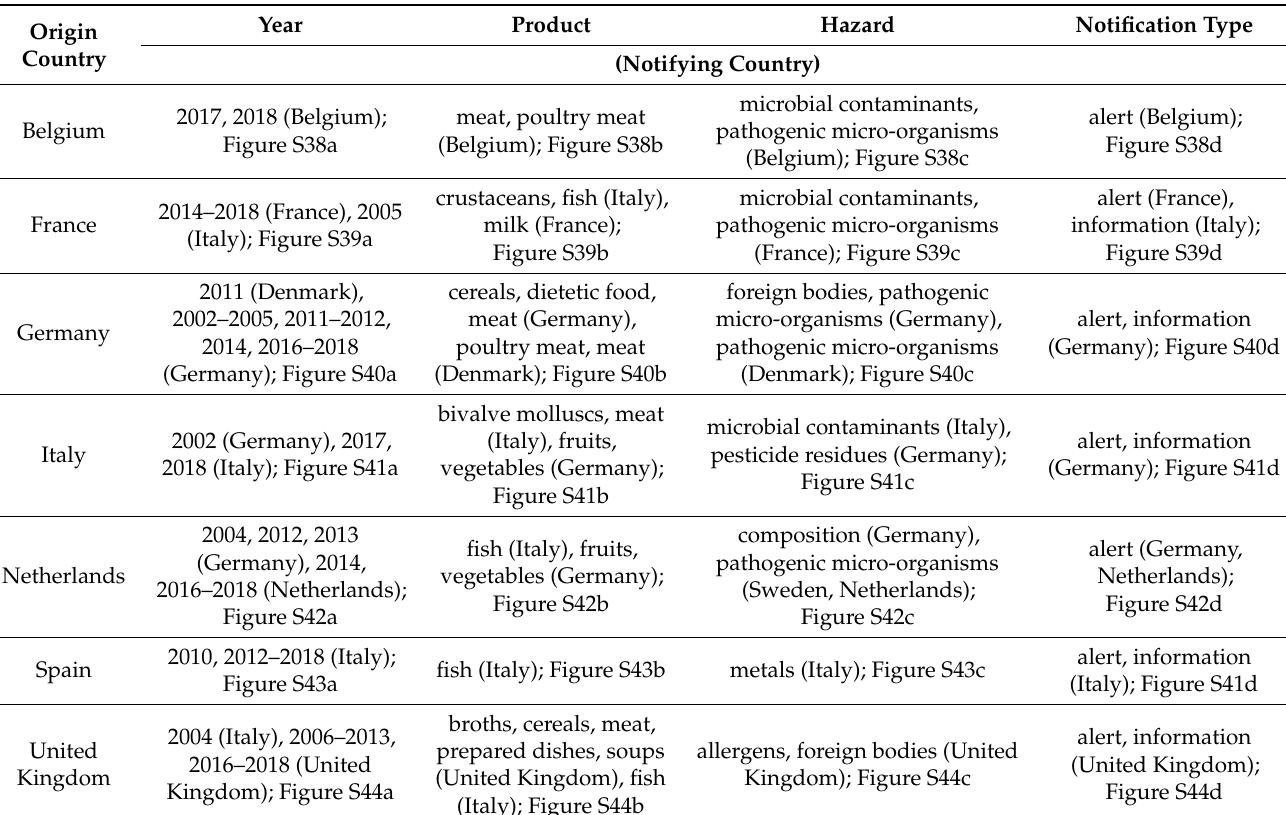
Table 6. Results of two-way joining cluster analysis related to notifications on food in the